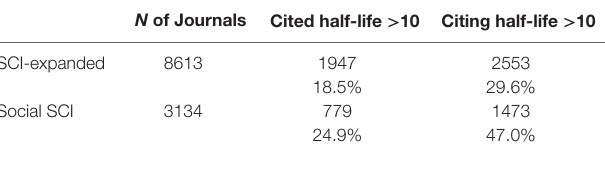
TaBle 1 | Journals with cited and citing half-life of more than 10 years in Jcr